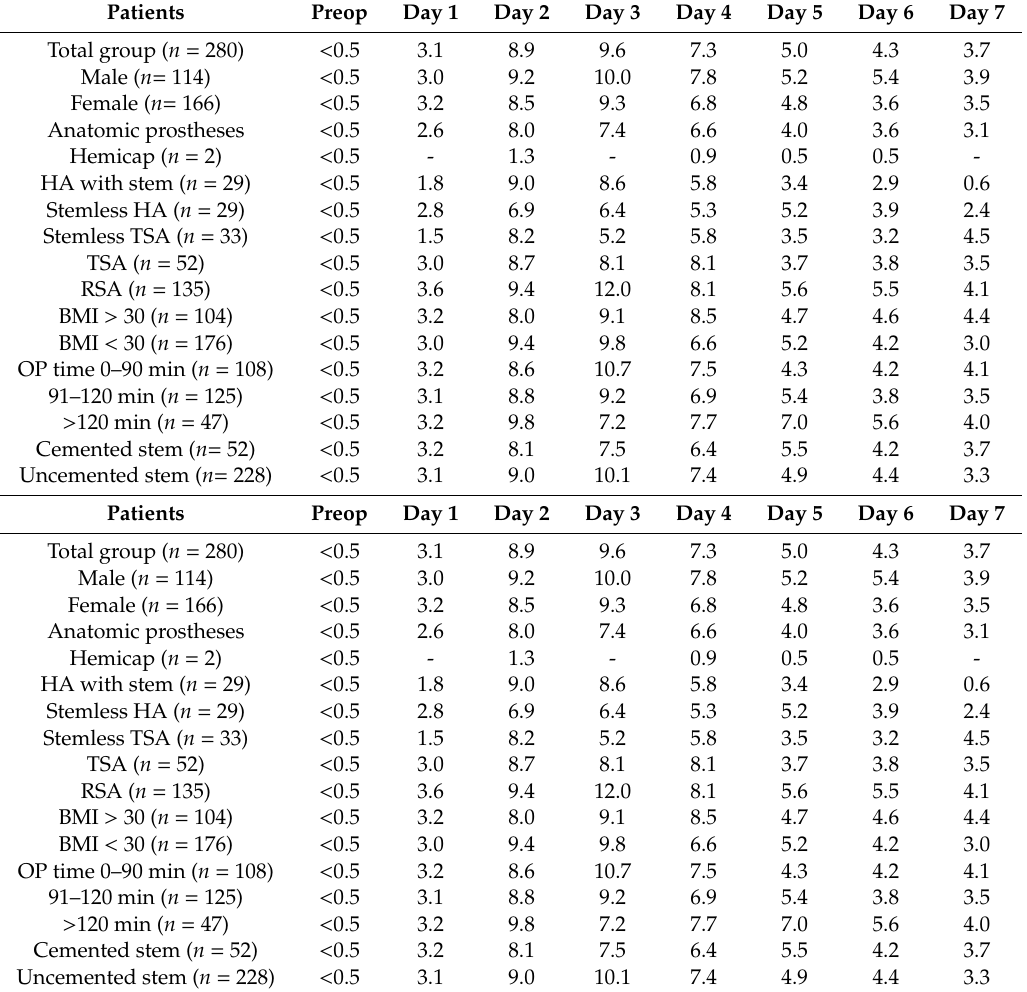
Table 3. Overview of mean postoperative C-reactive protein levels in mg / dL on di ff erent days following shoulder arthroplasty according to the di ff erent subgroup analysis.